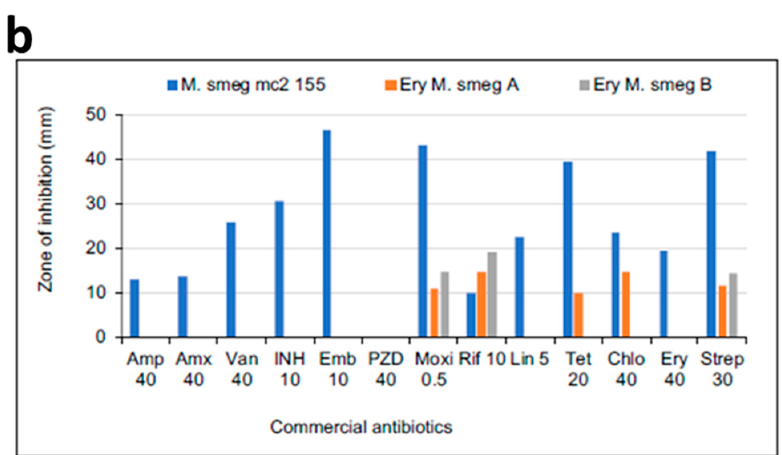
Figure 2. Isolation of two clones of MDR Mycobacterium smegmatis . ( a ) Schematic representation of the procedure used for isolating the two clones of erythromycin-resistant Mycobacterium smegmatis . Following the 5th repeat for generating resistant clones of Mycobacterium smegmatis , in vitro, (R5), a 10-fold serial dilution of the bacterial culture was performed. The 10 − 6 culture dilution was spread on a M7H10 agar plate, from which two distinct colonies of acid-fast bacilli were isolated and identified as erythromycin-resistant Mycobacterium smegmatis A and B. ( b ) Drug susceptibility pattern of